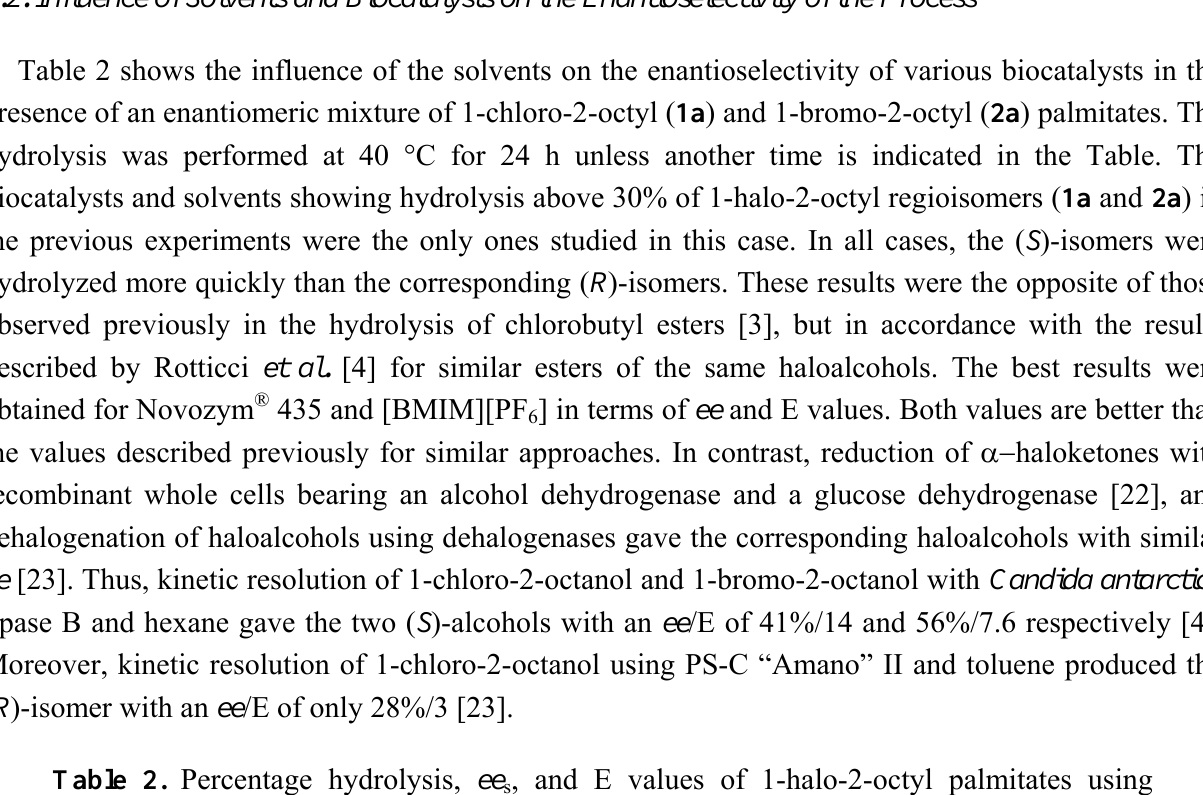
, and E values of 1-halo-2-octyl palmitates using s